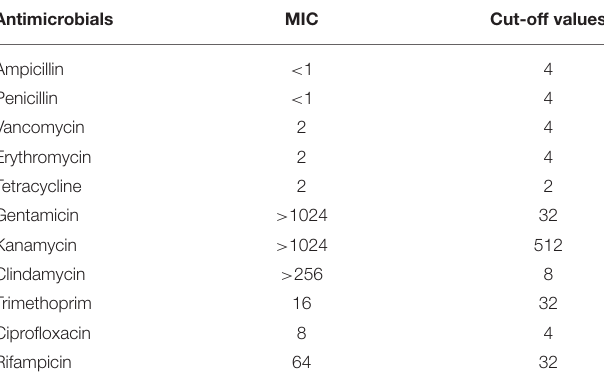
TABLE 2 | Minimum inhibitory concentrations (MICs) of Enterococcus durans KLDS6.0930 toward antimicrobials and the microbiological cut-off values.